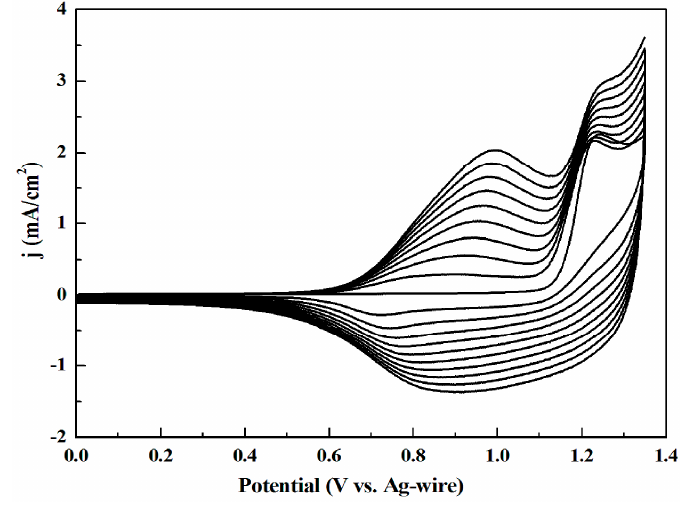
Figure 1. Cyclic voltammetry (CV) curves of